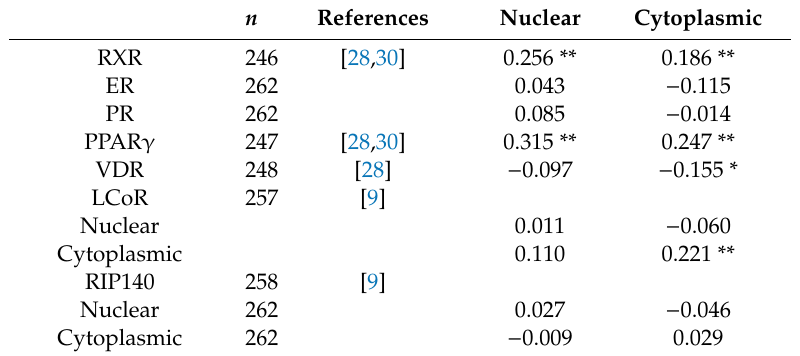
Table 3. Correlation between THR β 1 expression and nuclear receptors and related coregulators.